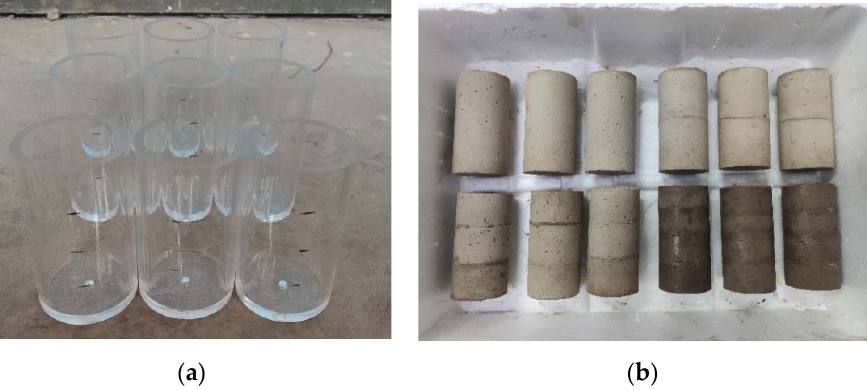
Figure 2. Filling Mold and Filling Body Sample; ( a ) Filling Mold, ( b ) Filling Body Sample.